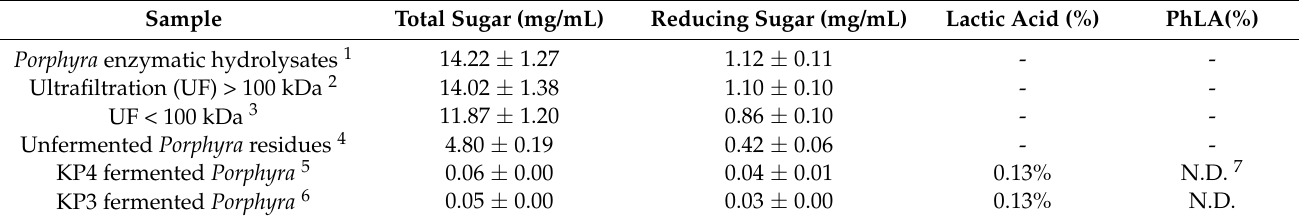
Table 1. Analysis of total sugar, reducing sugar, lactic acid, and phenyllactic acid (PhLA) concentration of Porphyra enzymatic hydrolysates, Porphyra ultrafiltration eluate, and unfermented and fermented Porphyra residues. Each value is mean ± standard deviation (n =